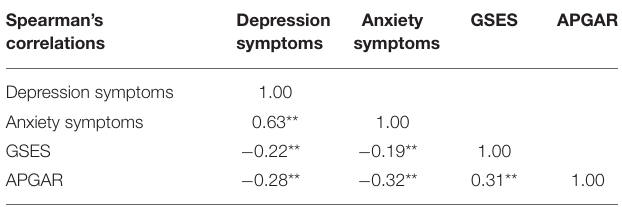
TABLE 2 | Spearman’s correlations between study